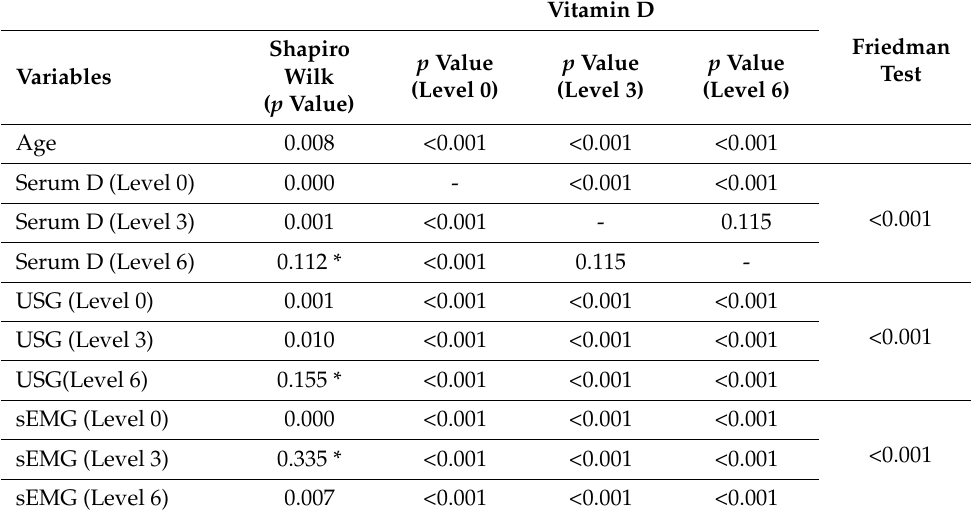
Table 5. Testing Vitamin D with Continuous Variables and Three Related Sample Testing.